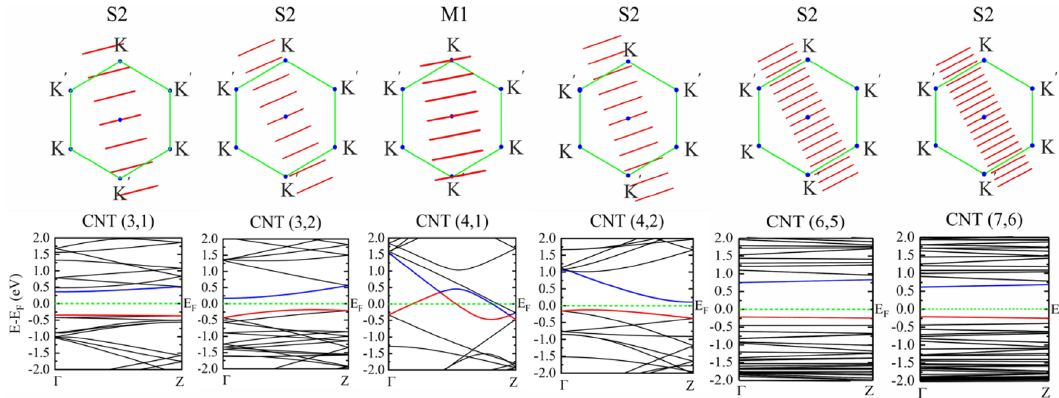
Figure 3. Top: cutting lines in zone folding illustration of chiral CNTs. Bottom: the corresponding DFT electronic band structures. Valence and conduction bands are represented in red and blue colours, respectively. Fermi energy E F is set to zero.